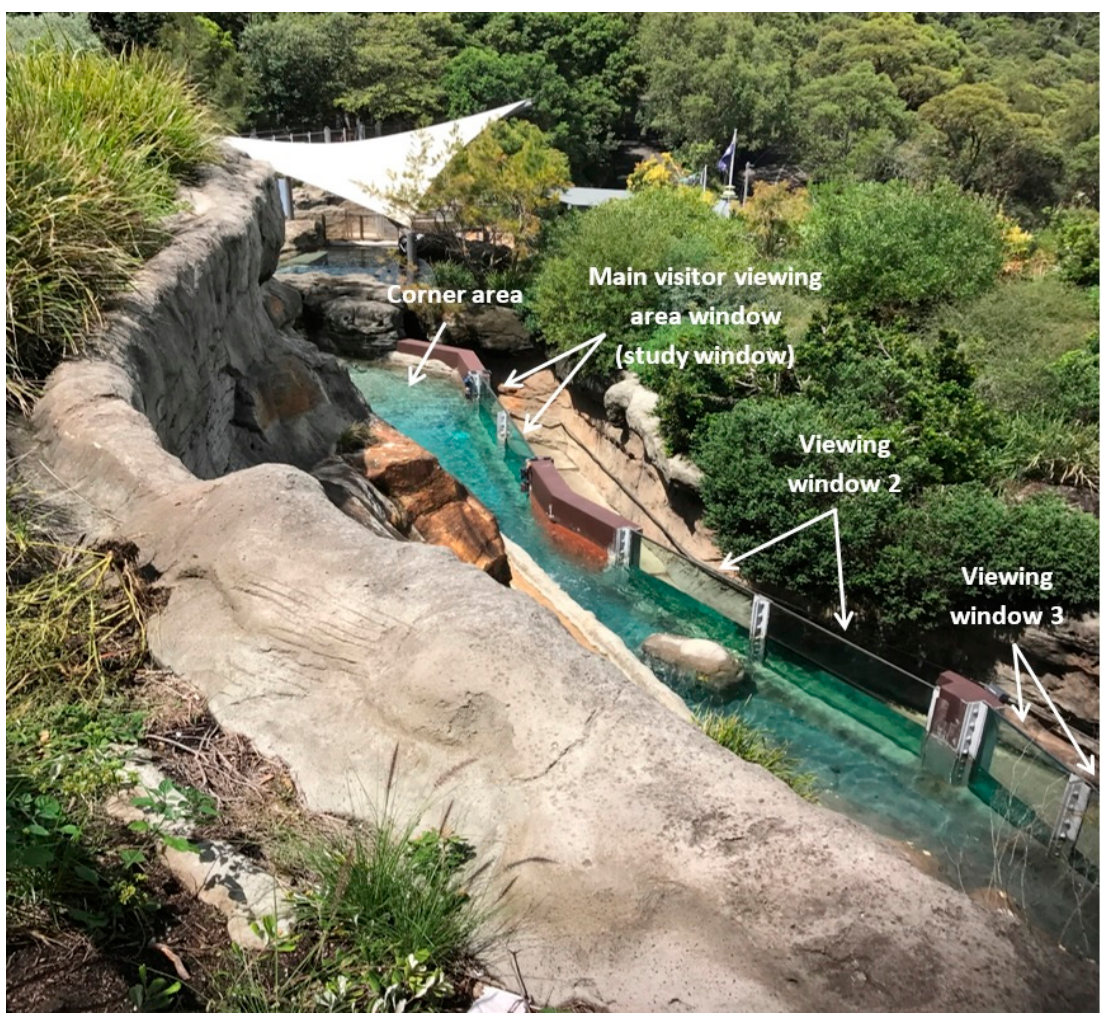
Figure 1. The Great Southern Oceans penguin exhibit at Taronga Zoo. Focus area was the